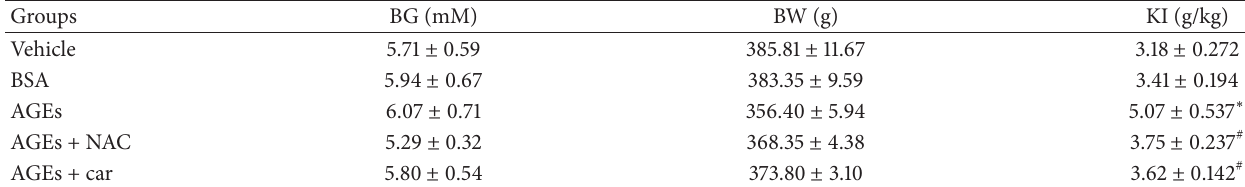
Table 1: General parameters in